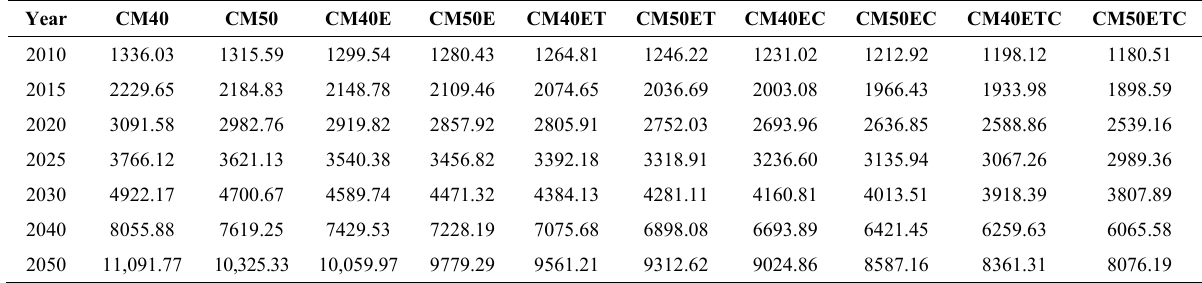
Table A4. The government receipts in all scenarios during 2010–2050 (Billion